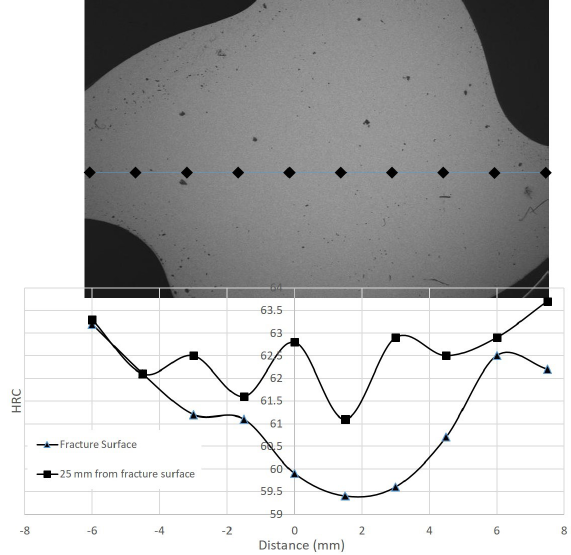
Figure 7: Difference hardness distribution between fracture surface and surface layer in distance of 25 mm from fracture